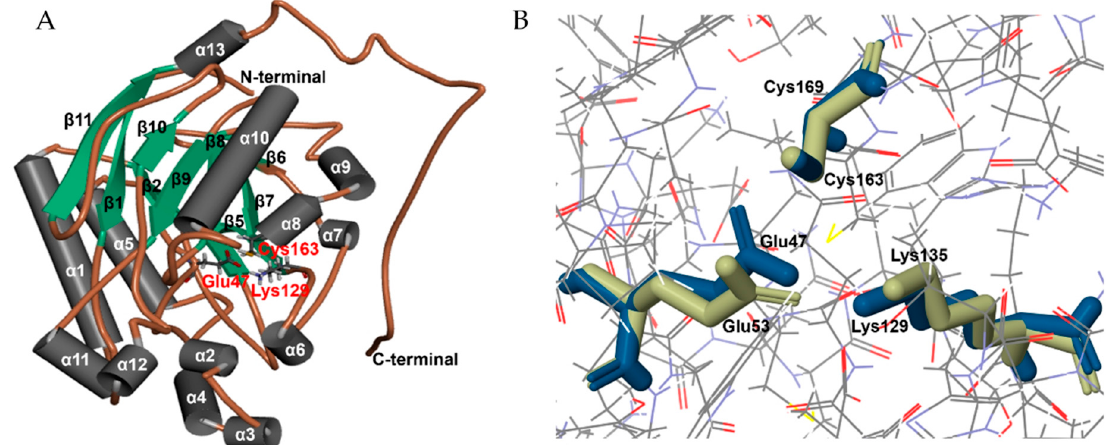
Figure 2. Homology modeling and the catalytic residues of NitAF. ( A ) Complete model of wild-type NitAF showing the catalytic pocket. The crystal structure of the protein Nit6803 from Syechocystis sp. PCC6803 was used as a template. ( B ) The catalytic residues of NitAF and Nit6803. The catalytic residues of NitAF (Cys-163, Glu-47, and Lys-129) and Nit6803 (Cys-169, Glu-53, and Lys-135) are similar with regard to position and orientation.